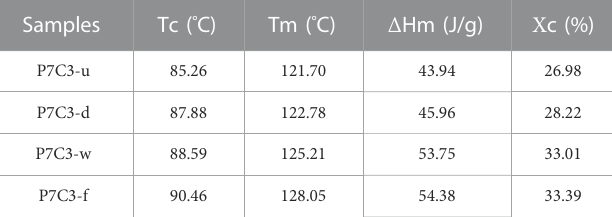
TABLE 2 DSC crystallization parameters of PBAT/CaCO 3